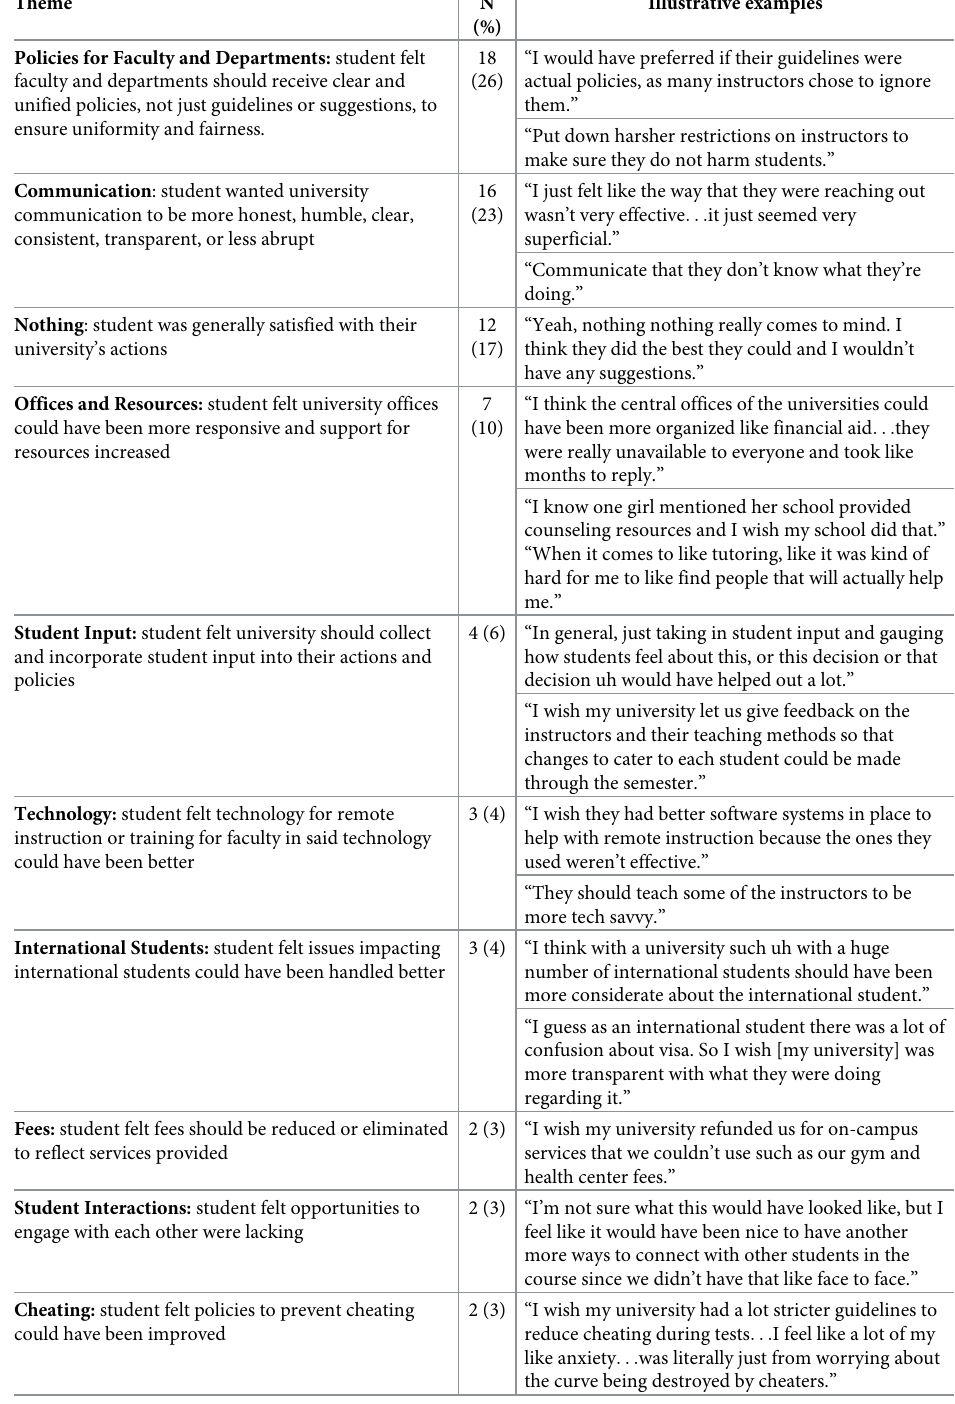
Table 8. Things students wish their university had done better (N = 59 participants, N = 69